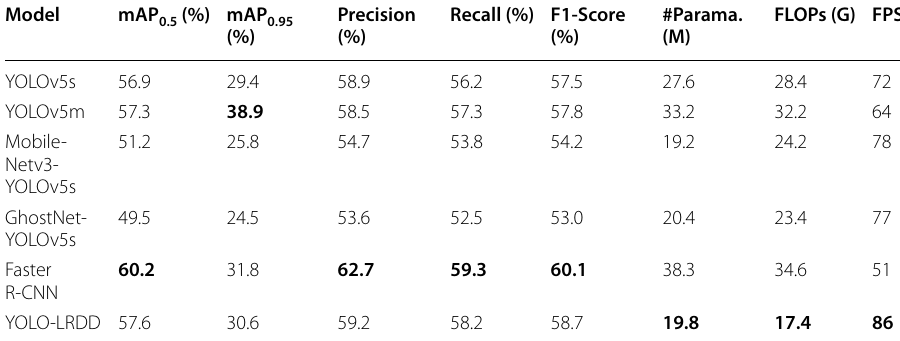
The best results are marked in bold